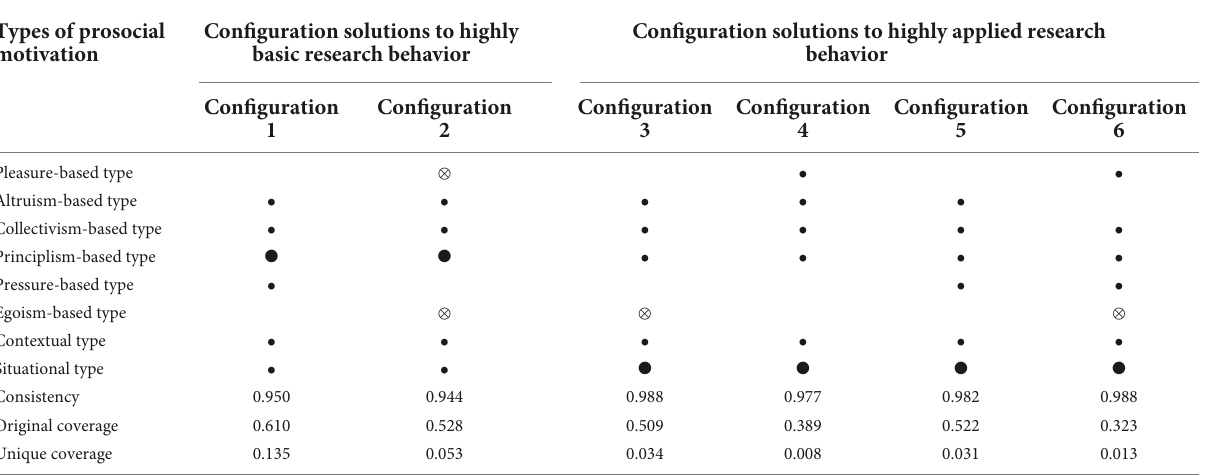
TABLE 5 Configuration solutions to highly basic research behavior and highly applied research